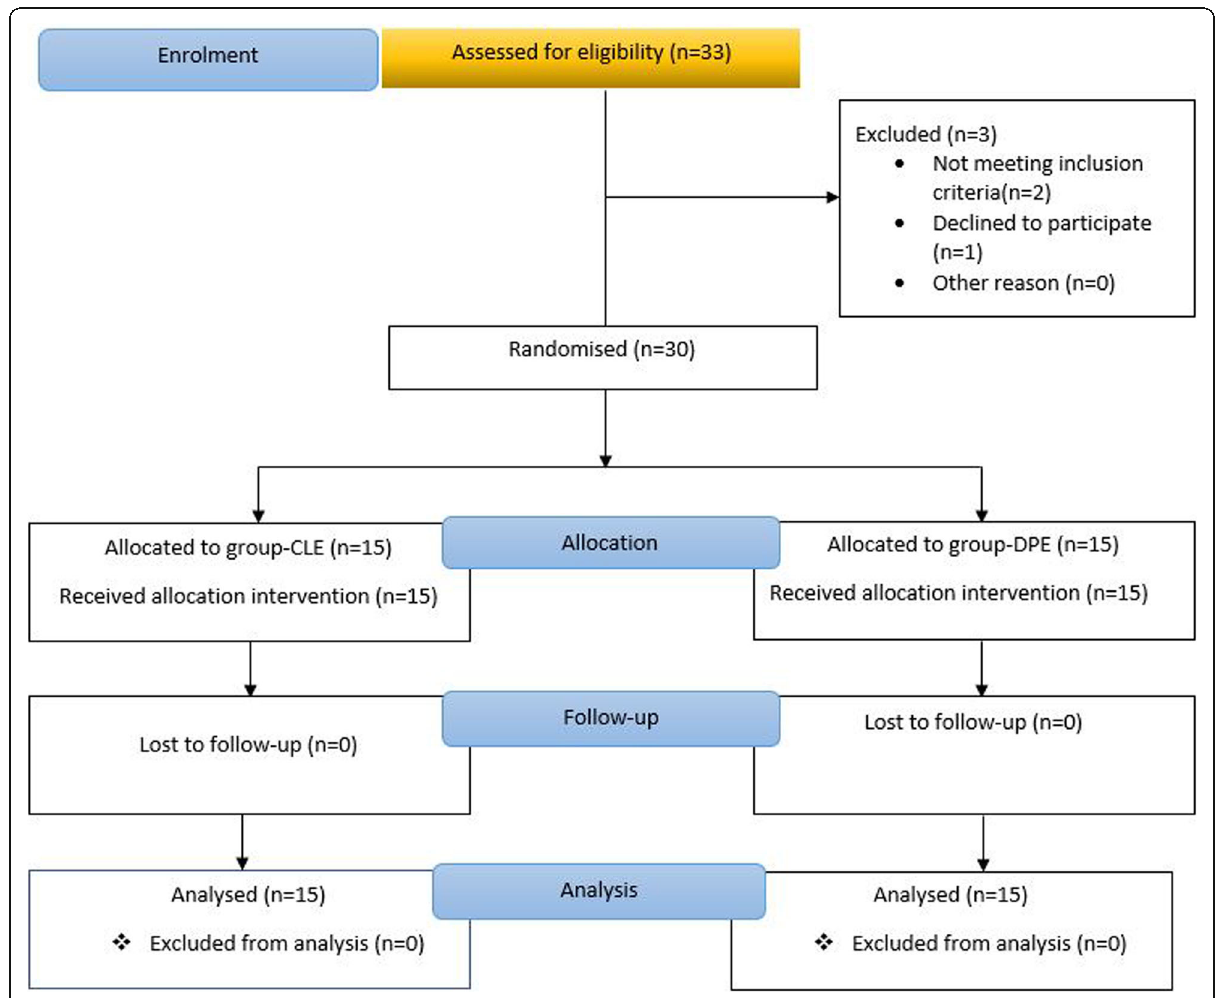
Fig. 1 CONSORT flow diagram. CLE conventional lumbar epidural, DPE dural puncture